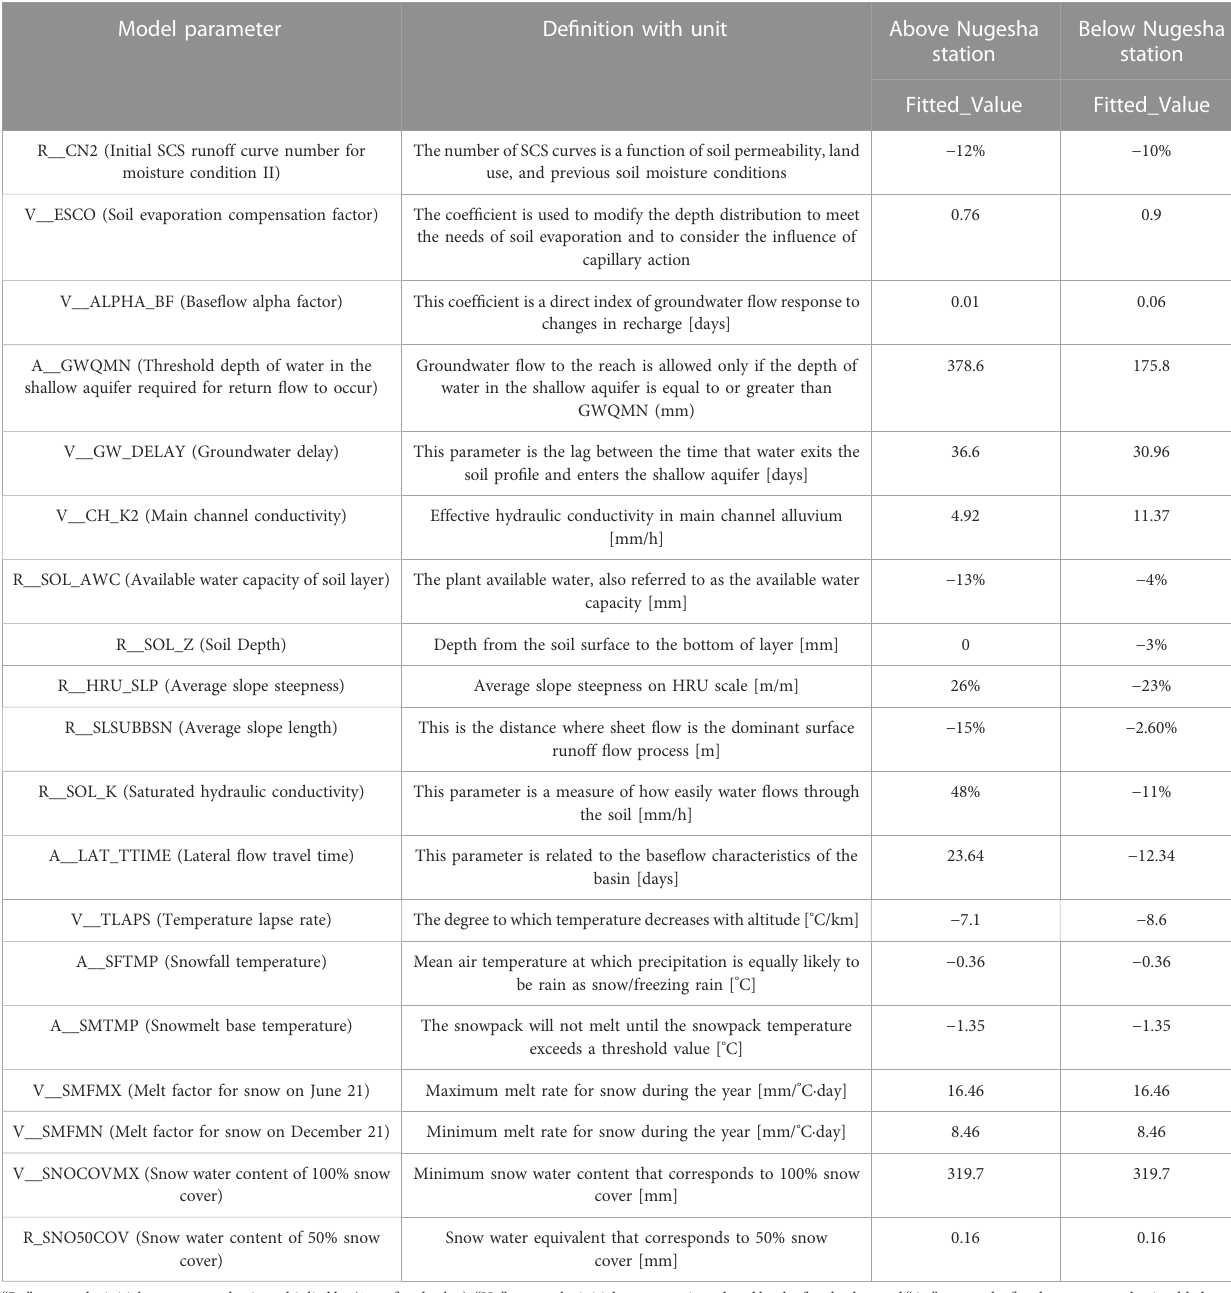
TABLE 3 Sensitive parameters for the Yarlung Zangbo River Basin. Model parameter De fi nition with unit Above Nugesha